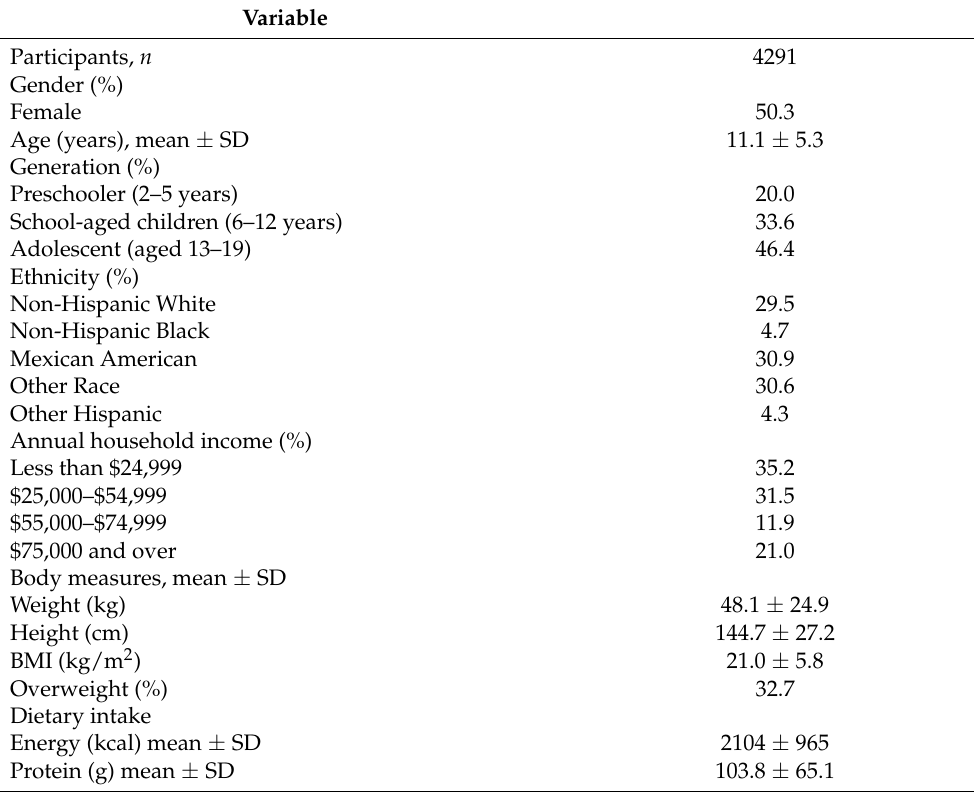
Table 1. Sample demographic and nutritional characteristics. BMI—body mass index.